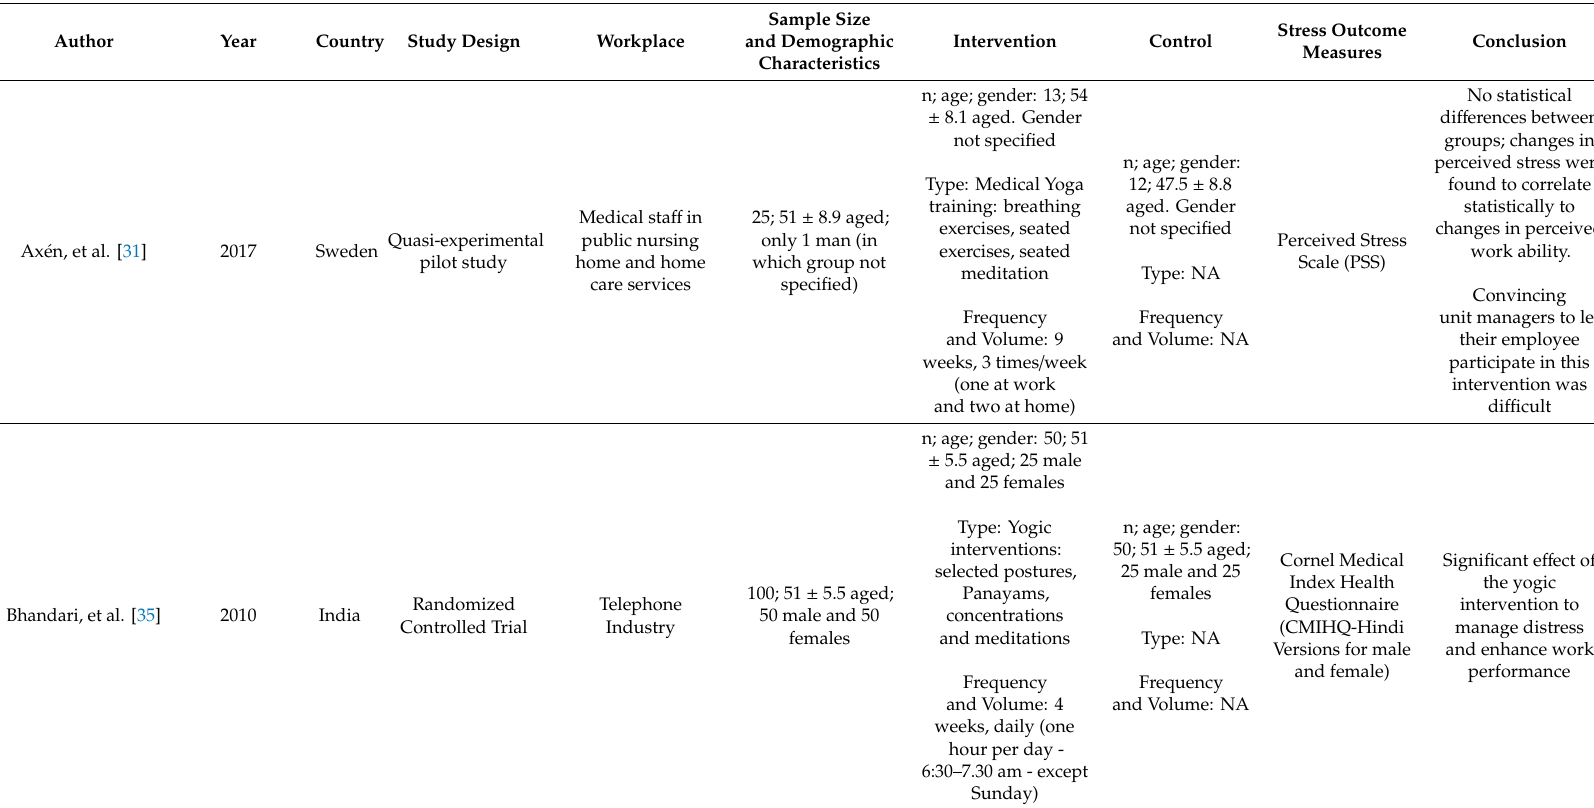
Table 1. Characteristics of included